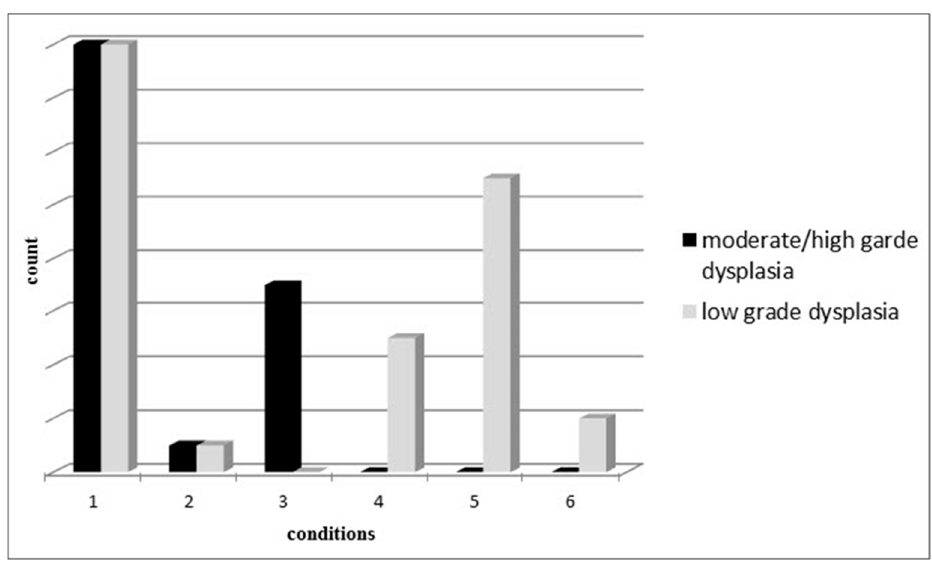
Figure 2. Synchronous assessment of dysplasia degree and the pathological state of the specimens.